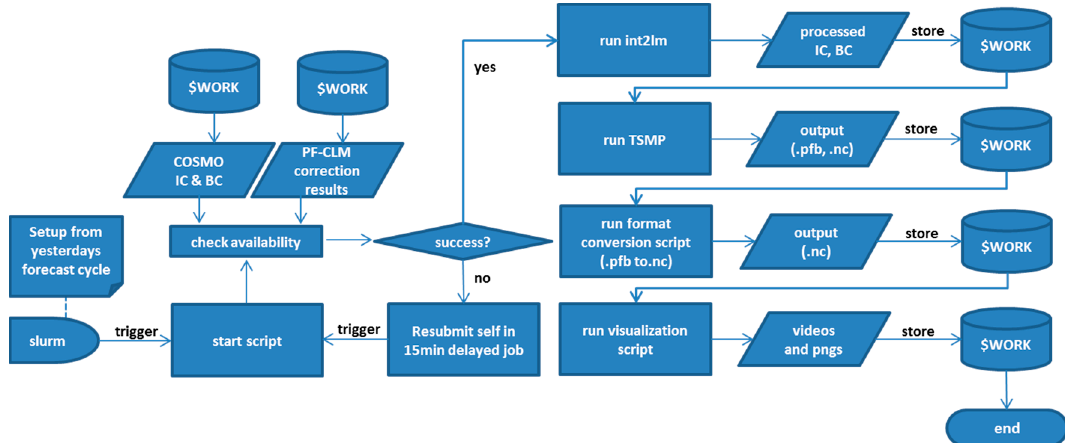
Figure 3. Flowchart for both the EU and NRW monitoring system implemented in the forecast jobscript running on the compute nodes of JURECA at JSC. $WORK indicates the execution of the respective workflow step in the working or scratch directory of the HPC environment. Note that both monitoring runs are based on the same workflow.